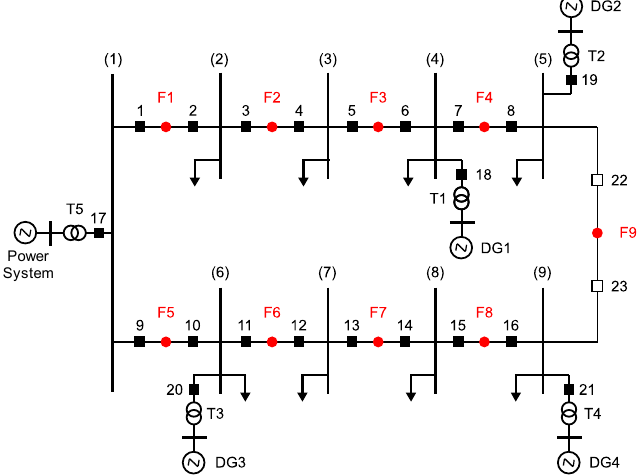
Figure 3. Canadian distribution network considered as a benchmark scenario in [26,34] and the present study.